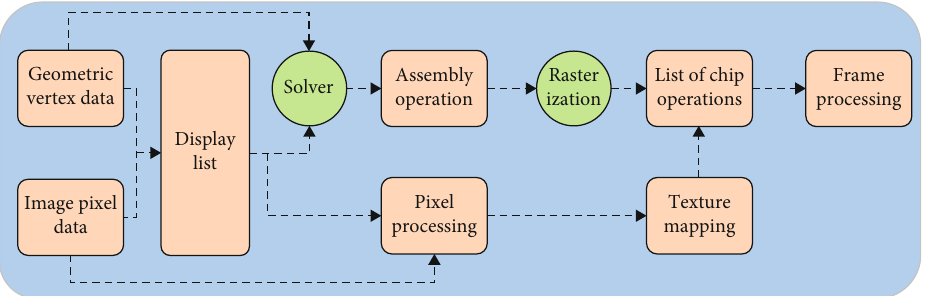
Figure 2: OpenGL basic work fl ow fl ow